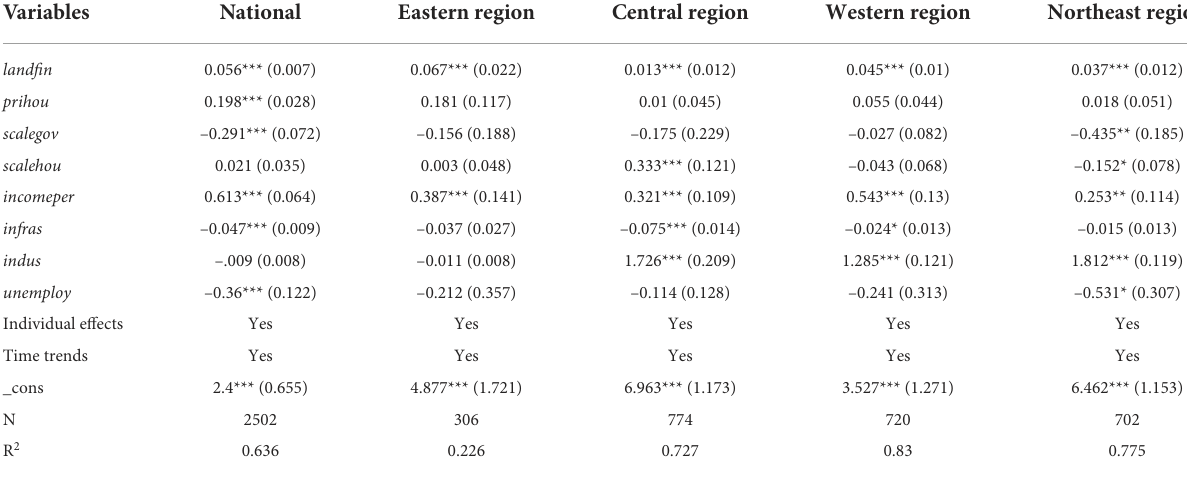
TABLE 6 The mediating effect test results of housing prices.